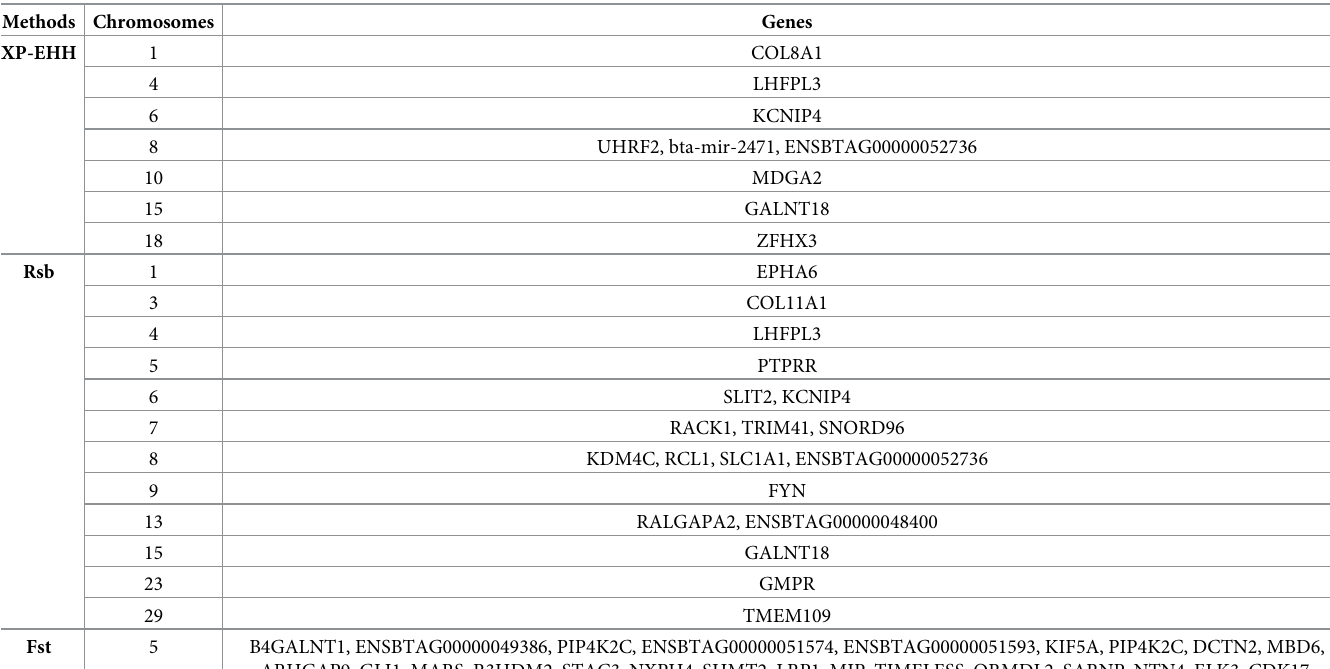
Table 1. Genes located in selection signatures for Canchim vs.